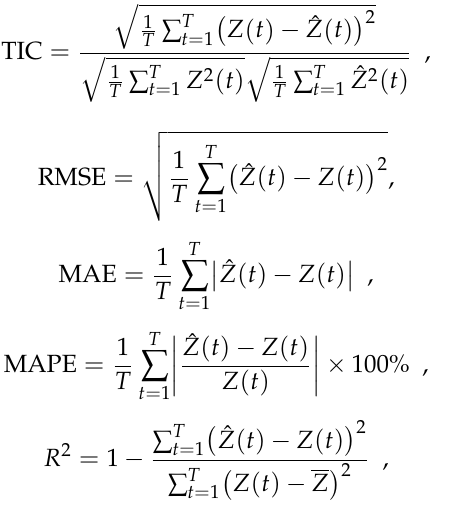
Figure 4. PM2.5 concentration in Beijing.